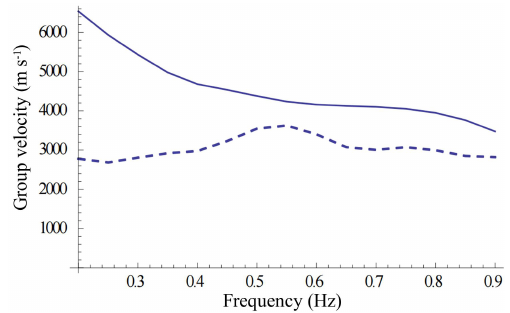
Figure 11. Example of dispersion curves corresponding to the fun- damental and first-order higher mode of Rayleigh wave estimated from EGFs. The dashed line denotes the fundamental mode and the solid line denotes the first higher mode.